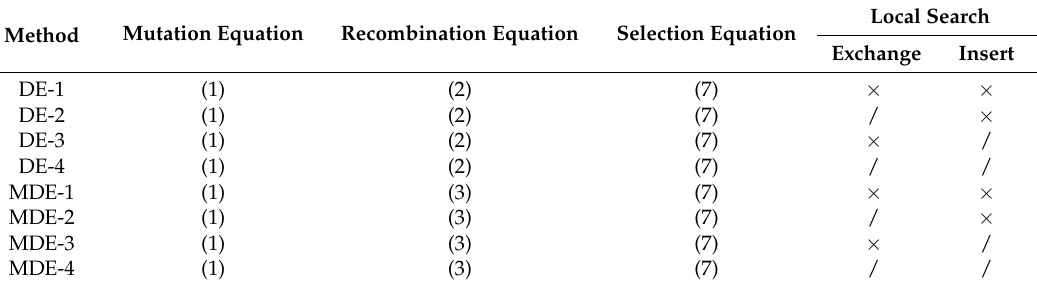
Table 13. Details of the proposed